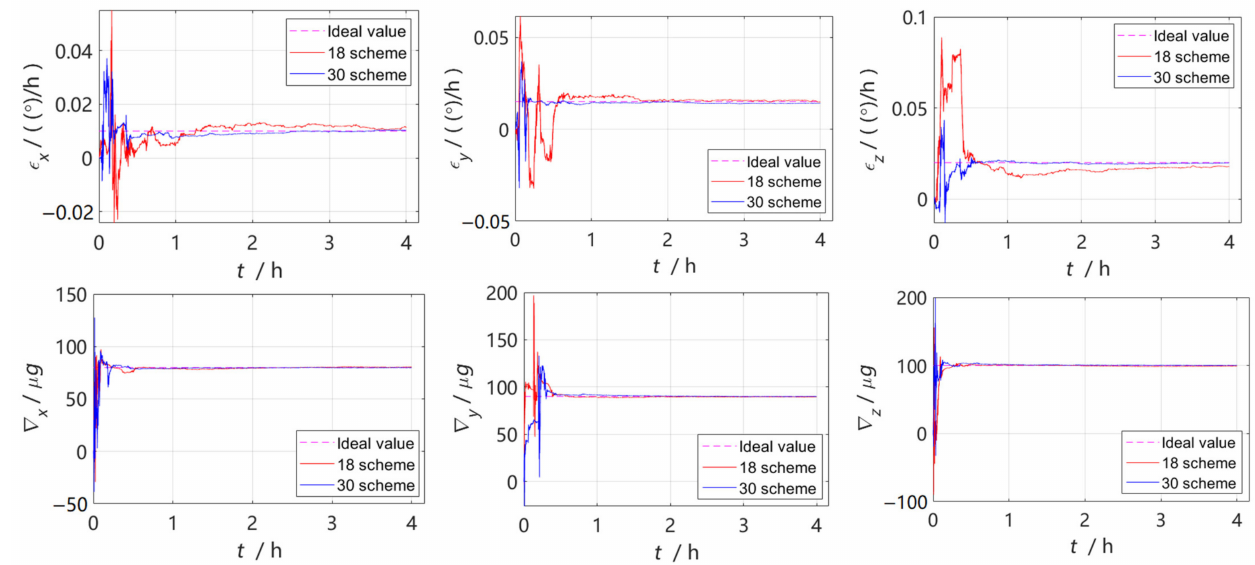
The Kalman filter estimation curve is shown in Figure 1, where the pink dotted line represents the ideal error value set, the red solid line represents the calibration curve of the 18-position scheme, and the blue solid line represents the calibration curve of the 30-position scheme. From the convergence effect, most of the error parameters of the 30-position scheme converged quickly, of which the gyroscope constant error and part of the installation error convergence effect were the most obvious.